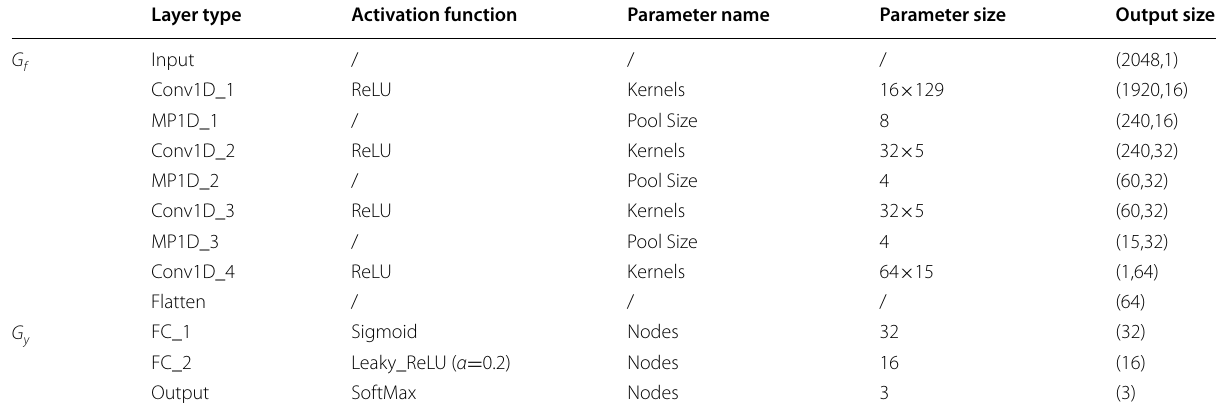
Table 4 Structures of G